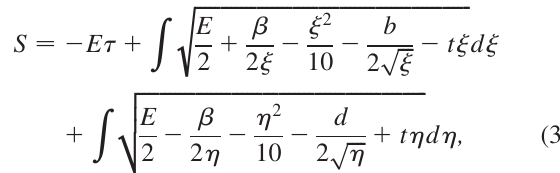
FIG. 4. Same as Fig. 2 except the force coefficients are different and the initial conditions are taken to be x ¼ 0 : 95 , p ¼ 0 : 1 ( E (cid:3) 1 : 15 and (cid:1) (cid:3) 1 : 356 y ¼ (cid:1) 0 : 8 , and p y